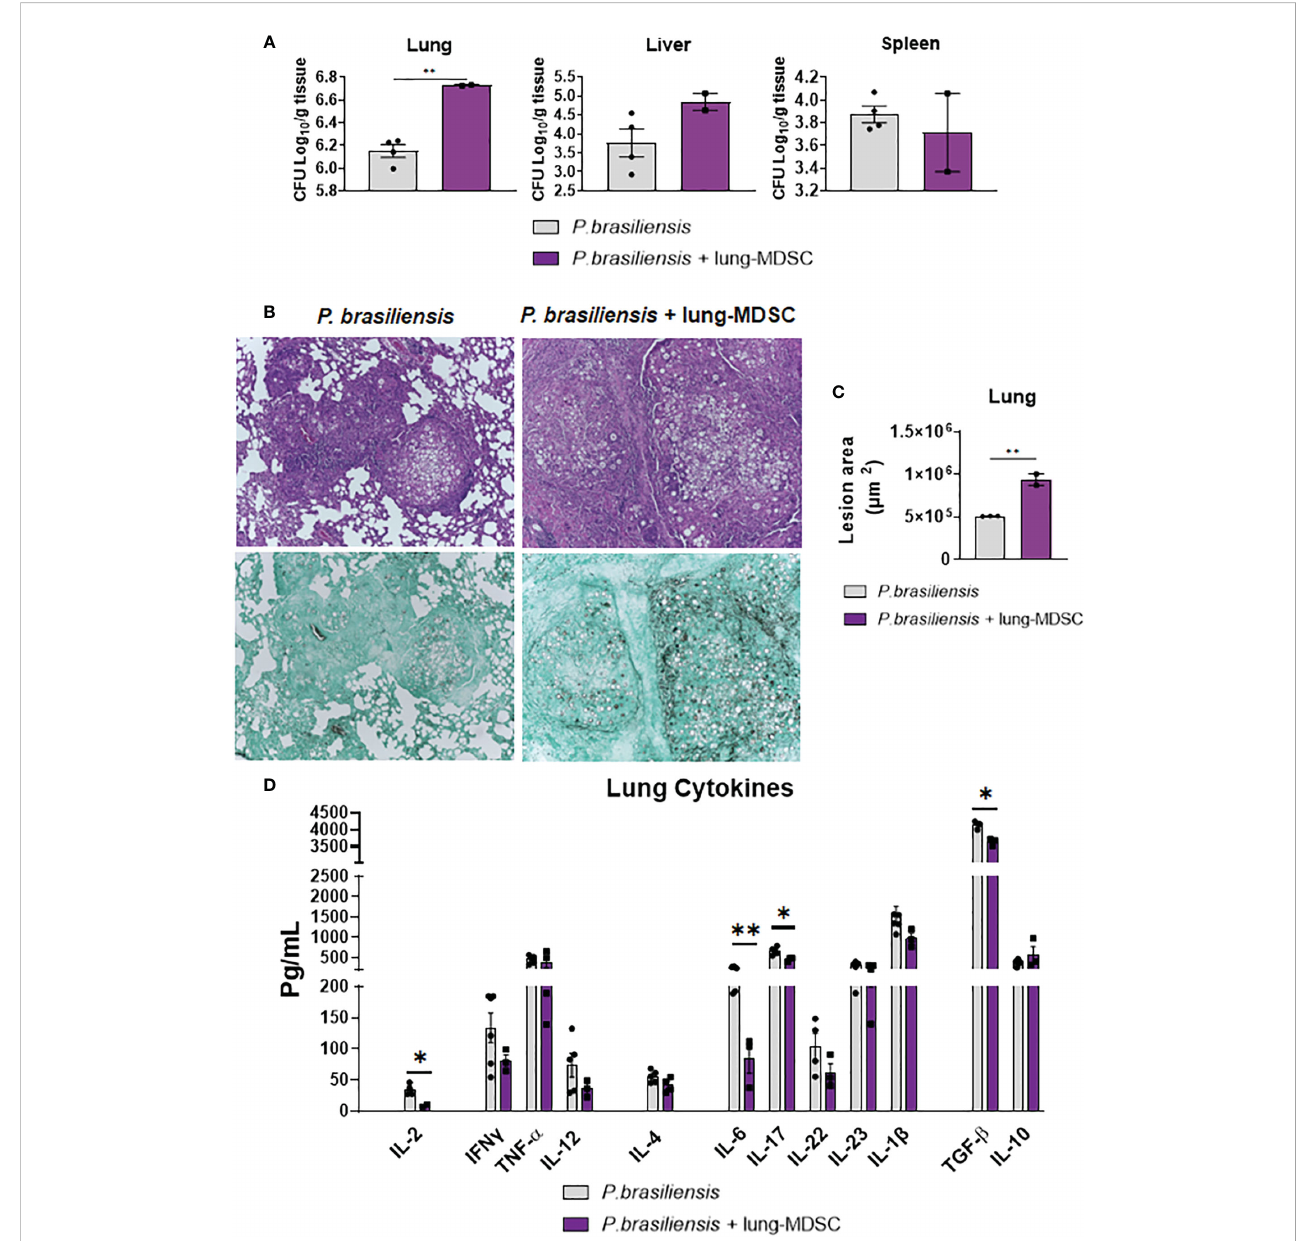
FIGURE 11 Adoptive transfer of MDSCs to P. brasiliensis -infected mice increases disease severity. C57BL6/WT mice were infected with P. brasiliensis ; after 2 weeks, the lungs were obtained and MDSCs were isolated. The cells were transferred into recipient mice that had been infected with P. brasiliensis 7 weeks before the transfer. Infected control animals received only DMEN medium. Seven days after the adoptive transfer of Lung-MDSCs, disease severity was measured by CFU counts (A) . Photomicrographs of lung lesions of control and MDSC-recipient mice at week 8 of infection. Lesions were stained with hematoxylin-eosin (top panels) and Grocott (bottom panels) (B) . The total area of lung lesions was calculated in square micrometers of 5 microscopic fi elds per slide in 3-4 mice per group (C) . Pulmonary cytokines (IL-2, IFN- g , TNF- a , IL-12, IL-4, IL-6, IL-17, IL-22, IL-23, TGF- b , IL-1 b , and IL-10) were measured by ELISA in lung homogenates (D) . Data represent two independent experiments with 3-4 mice per group. For comparisons between two groups, the mean ± SEM was obtained and analyzed by the unpaired Student ’ s t -test. Differences were considered signi fi cant when: * p <0.05 and ** p